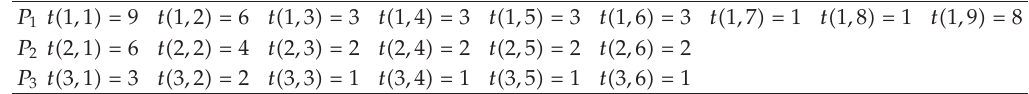
Table 1: The processing time of jobs.